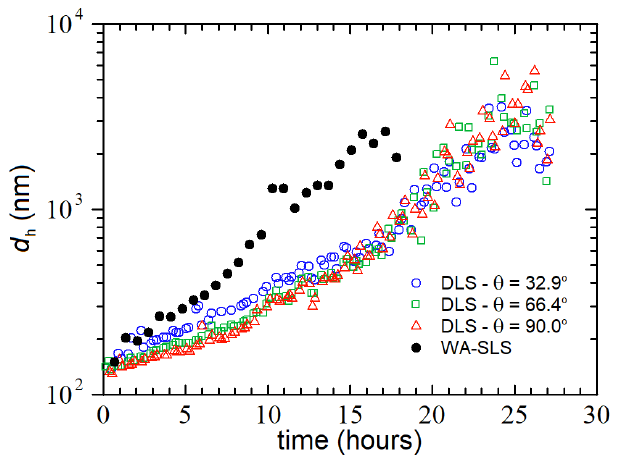
Figure 8. Comparison between the time evolution of the hydrodynamic diameters recovered via DLS at three different angles (open symbols) and the one recovered by using WA-SLS (dots). The latter one was estimated from the R G values (see Figure 7a), as described in the